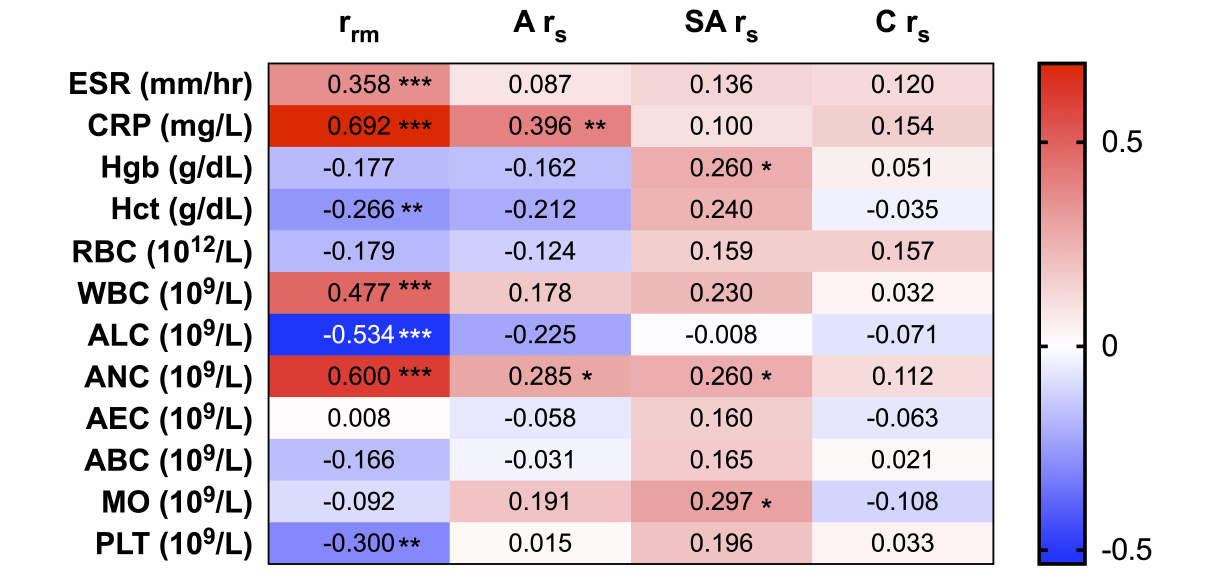
there was a strong negative r rm between PTX-3 and Hct, which was not observed in the NCA group ( Figure 4 ). During the acute phase, r s analysis between PTX-3 and CRP remained significantly positive in both groups. Analysis of the acute phase NCA group by r s revealed weak positive relationships between PTX-3 and ALC and MO. Similarly, analysis of the sub-acute phase revealed